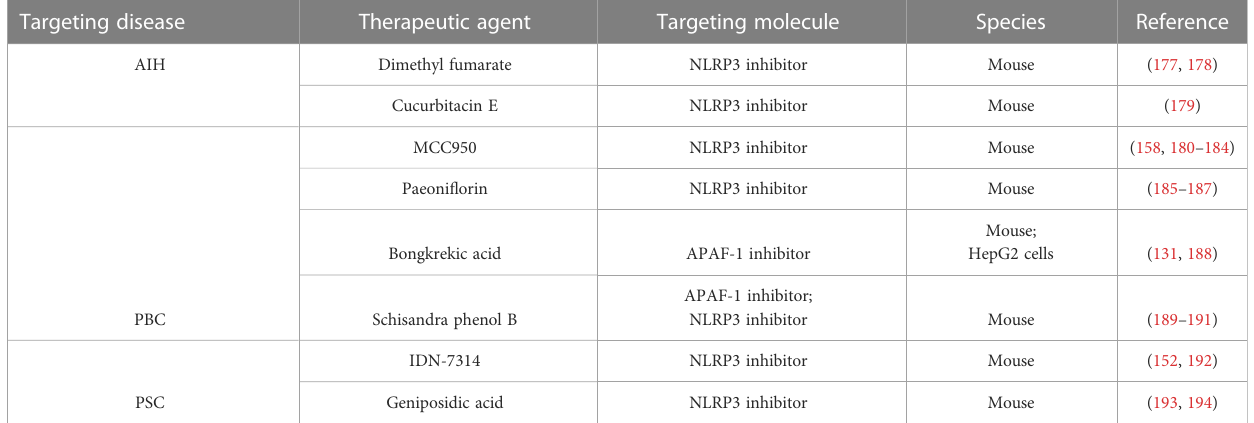
TABLE 1 Potential Therapeutic Agents for autoimmune liver disease. Targeting